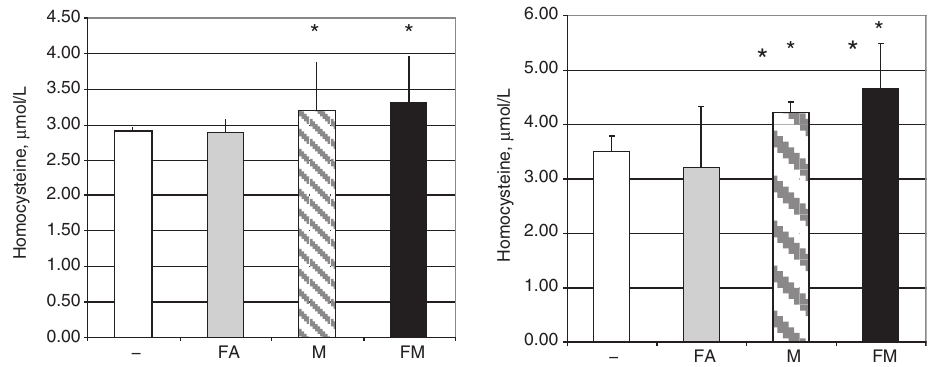
Figure 4 Homocysteine concentrations measured in the supernatants of immature (right picture) and maturing dendritic cells (left picture) (*p < 0.01) supplemented with folic acid (FA), methionine (M) and the combination of both compounds (FM). Significant differences are indicated by an asterisk (*p <